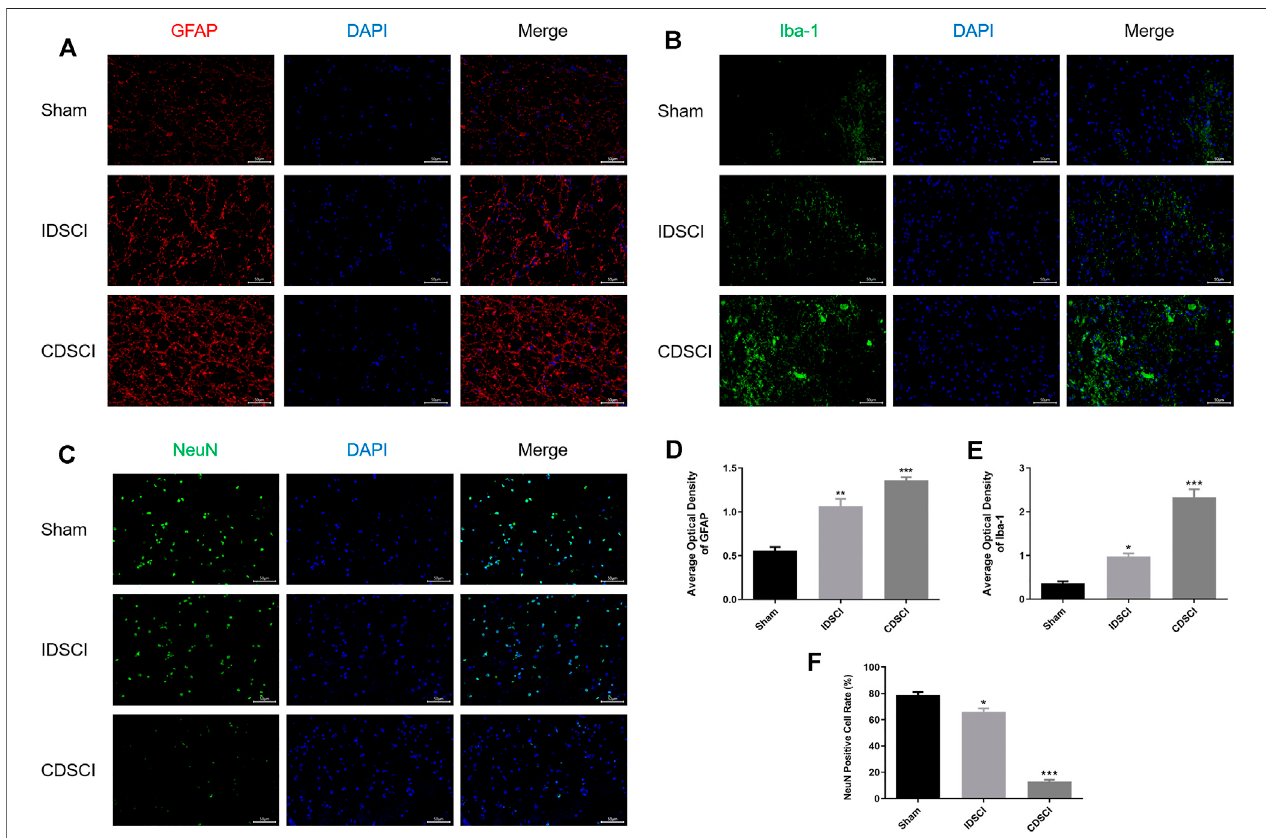
FIGURE6| Immuno fl uorescencestainingofGFAP,Iba-1,andNeuNinthecentralDSCIlesionsat7 daysafterDSCIindifferentgroups. (A) Representativeimages (200×,scalebar=50 μ m)ofGFAP(inred)andDAPI(inblue)staining. (B) Representativeimages(200×,scalebar=50 μ m)ofIba-1(ingreen)andDAPI(inblue)staining. (C) Representative images (200 ×, scale bar = 50 μ m) of NeuN (in green) and DAPI (in blue) staining. (D,E) The averaged optical density of GFAP, Iba-1, (F) and quanti fi cation of the NeuN-positive cells was measured ( n = 3). All values are expressed as means ± SD. * p < 0.05, ** p < 0.01, *** p < 0.001 vs. the sham group.